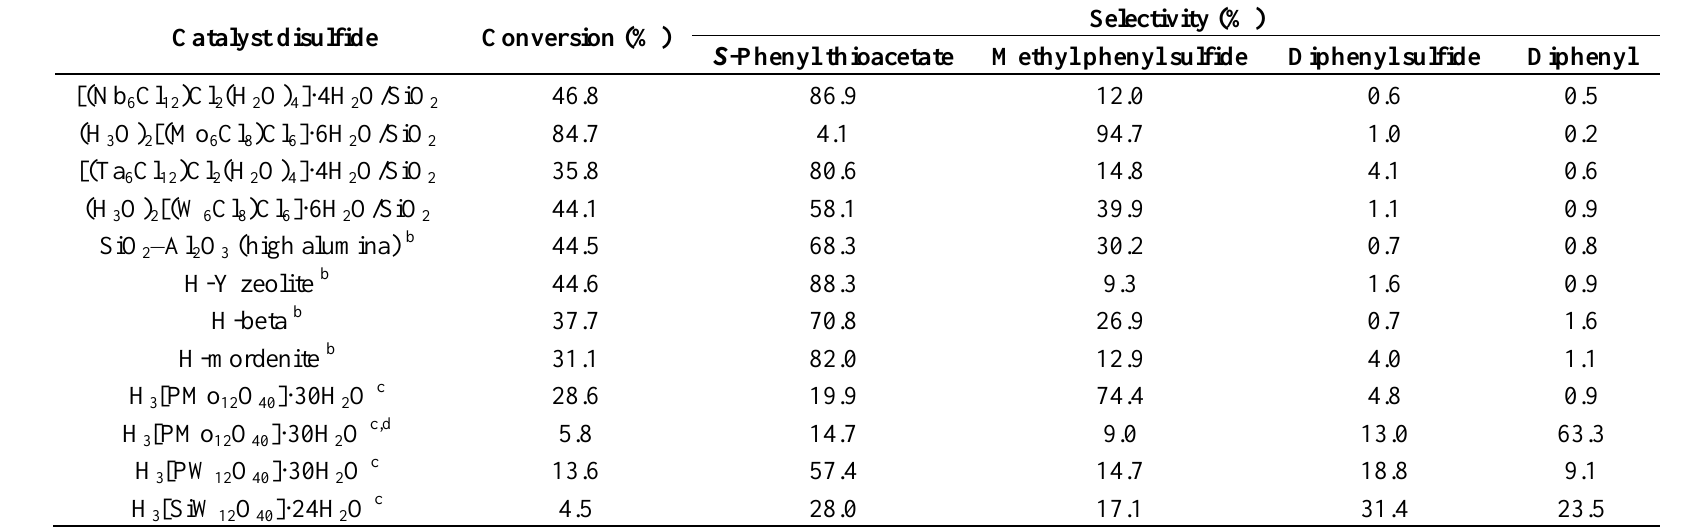
Table 11. S -Acetylation and S -methylation of benzenethiol with methyl acetate over various catalysts a . Catalyst